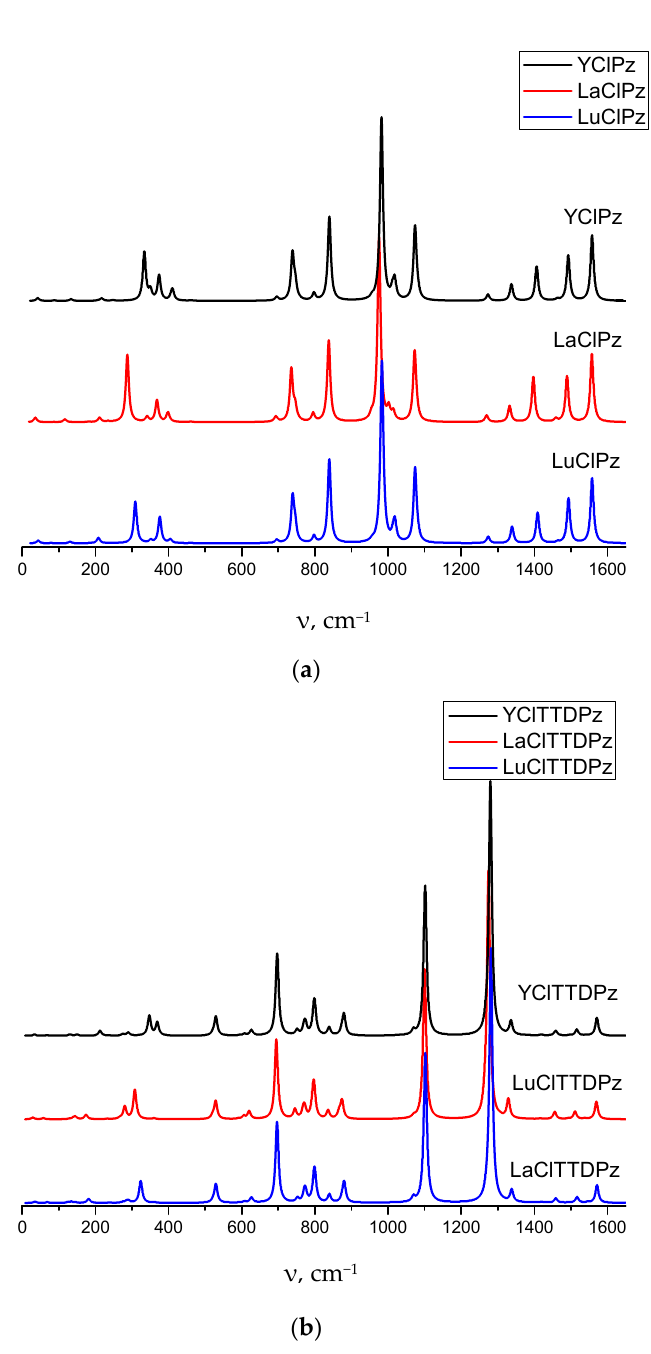
Figure 6. Simulated vibrational spectra of the MClPz ( a ) and MClTTDPz ( b ) complexes.